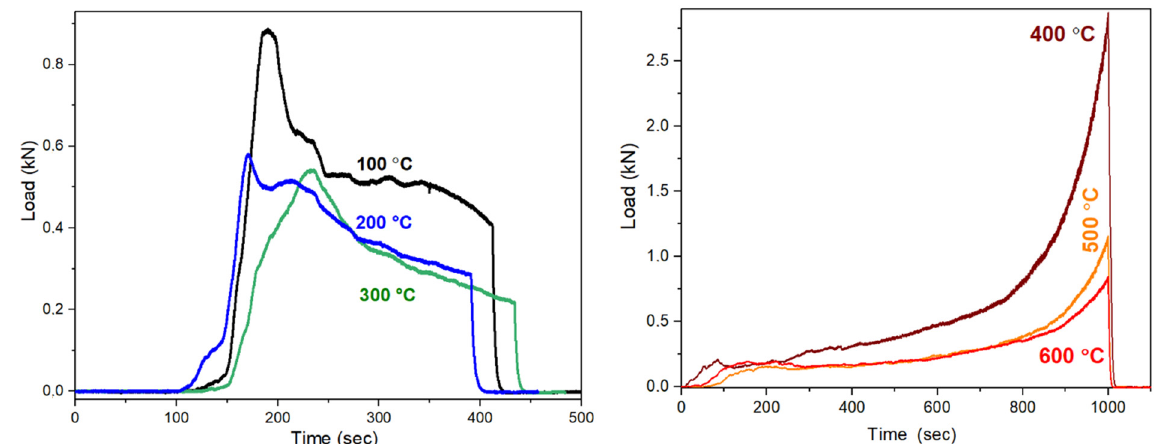
Figure 9. The load vs. time curves of the MTS compressive strength measurement of the synthetic composite heated at 100–300 °C and 400–600 °C.